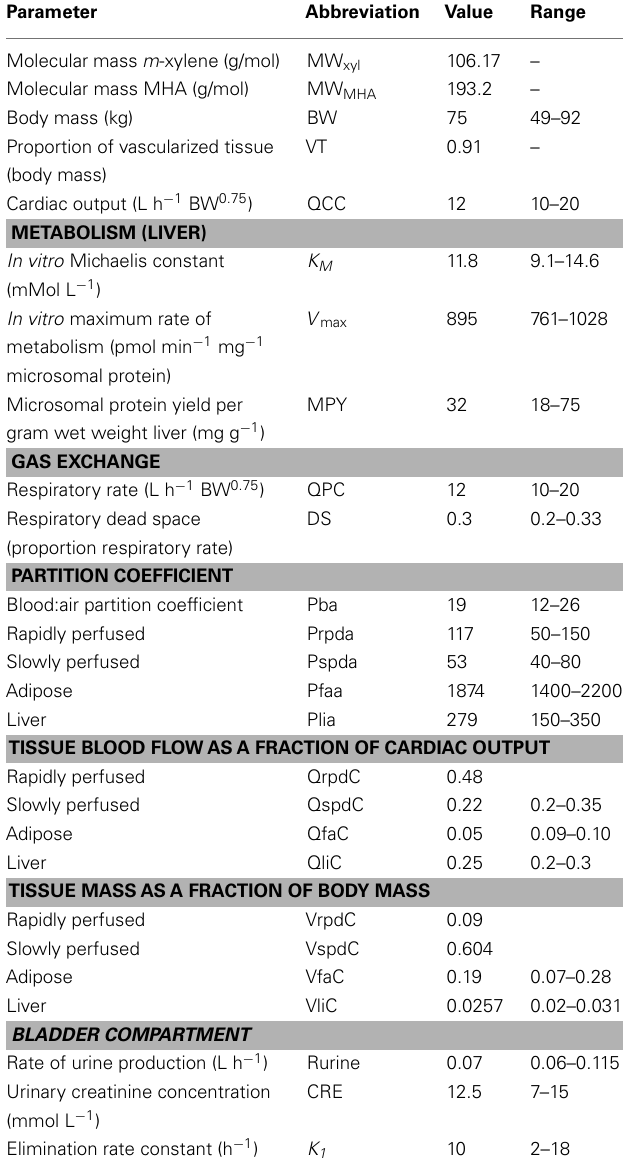
parameters used in the PBPK